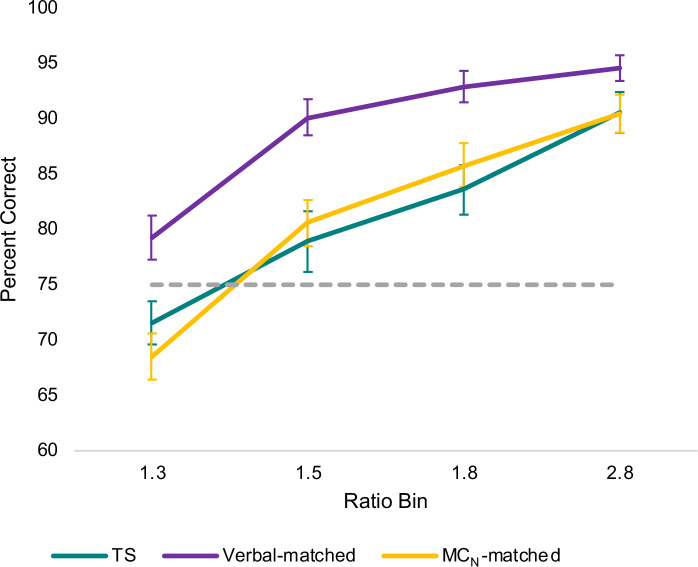
MCN accuracy across ratio bin.Relation between ratio bin (ratio of the dot arrays) and overall percent correct on the MCN task for each group. The threshold for reliably accurate magnitude comparison, which we define as accuracy of 75% or above, is marked by the dotted line. Error bars represent standard error of the mean. Data include n = 39 children with TS, n = 41 Verbal-matched children, and n = 40 MCN-matched children.